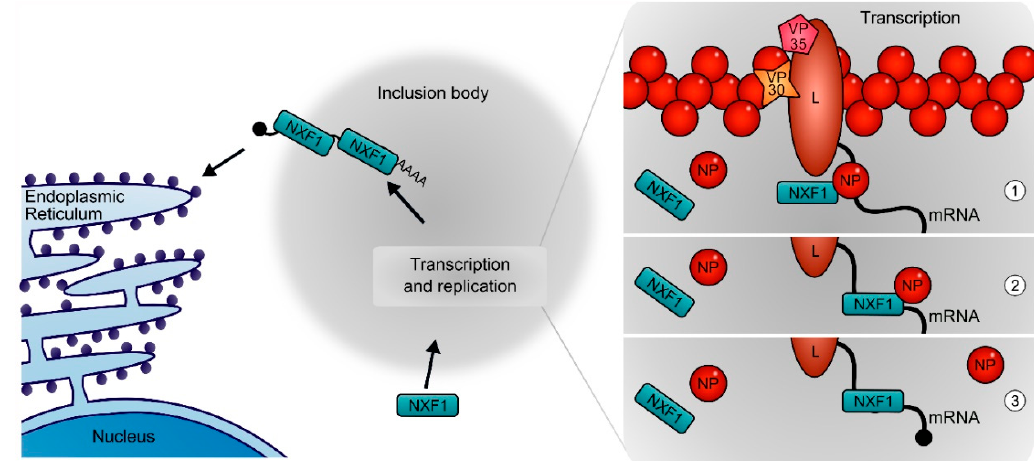
Figure 8. Model for the role of NXF1 and its interaction with NP and the viral mRNA during the EBOV life cycle. NXF1 enters inclusion bodies, which are the site of viral genome replication and transcription. Once in the inclusion bodies, NP recruits NXF1 to nascent mRNA during viral transcription ( 1 ). NXF1 then takes over the viral mRNA from NP ( 2 ), and thereby avoids encapsidation of the mRNA ( 3 ). After the completion of transcription, NXF1 together with the viral mRNA is exported from the inclusion bodies and transports it to ribosomes for translation.